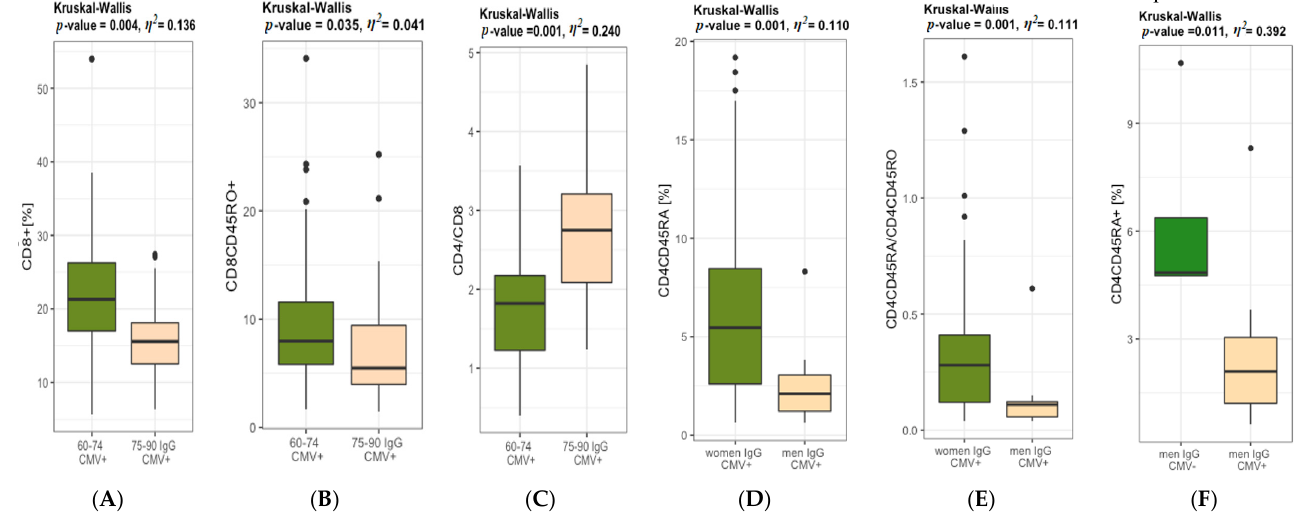
Figure 7. Distribution of T lymphocytes phenotypes in relation to CMV serostatus. Differences between 60–74 years of age ( n = 56) vs. 75–90 years of age ( n = 31) ( A – C ), older women ( n = 75) vs. older men ( n = 12) ( D , E ), older men IgG CMV − ( n = 4) vs. older men IgG CMV+ ( n = 12) ( F ). Abbreviations: CMV+ cytomegalovirus positive, CMV − cytomegalovirus negative. The measurements in groups were compared by the one-way ANOVA or the Kruskal-Wallis non-parametric test (if the normality assumption is violated), η 2 is a measure of effect size, SD standard deviation, Me median.